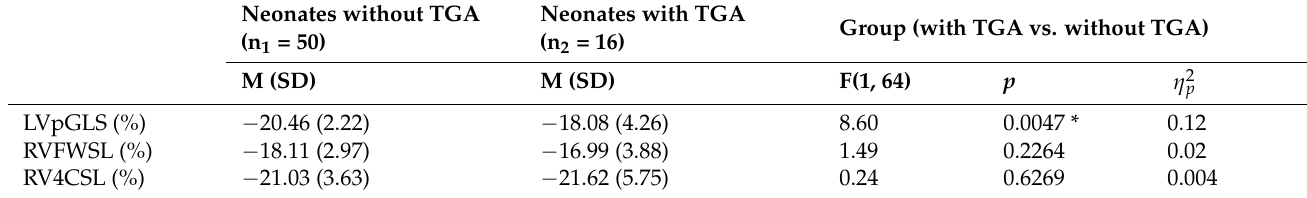
Figure 2. Scatter plots between the left- and right-ventricle-related longitudinal strain variables stratified by neonates with TGA and controls. TGA: transposition of great arteries; LVpGLS: left ventricle peak longitudinal strain; RVFWSL: right ventricle free-wall longitudinal strain; RV4SLC: right ventricle 4-chamber strain. Table 3. One-way analysis of variance (ANOVA) with group (neonates with TGA vs. neonates without TGA) as between-subject factor performed on the left- and right-ventricle-related longitudinal strain